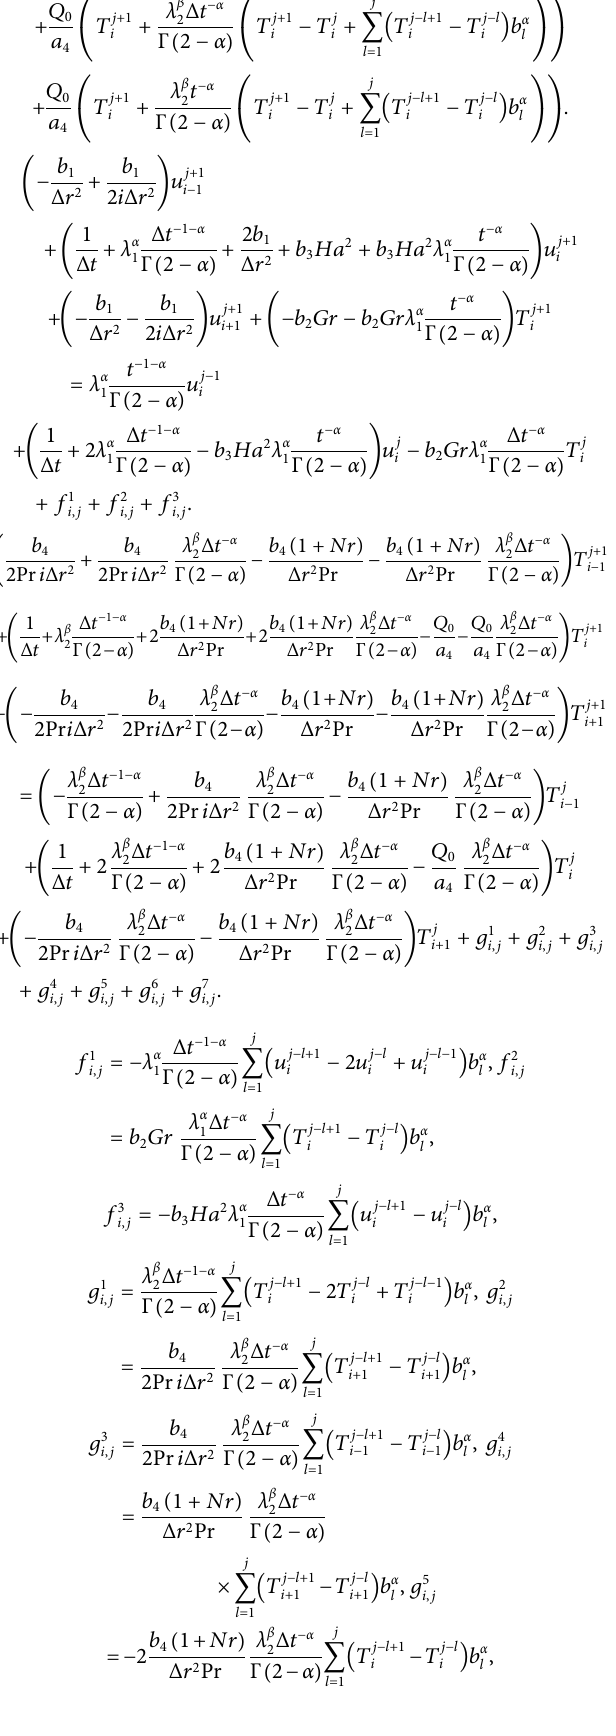
FIGURE 2 Impact of λ 1 on u ( r , t )